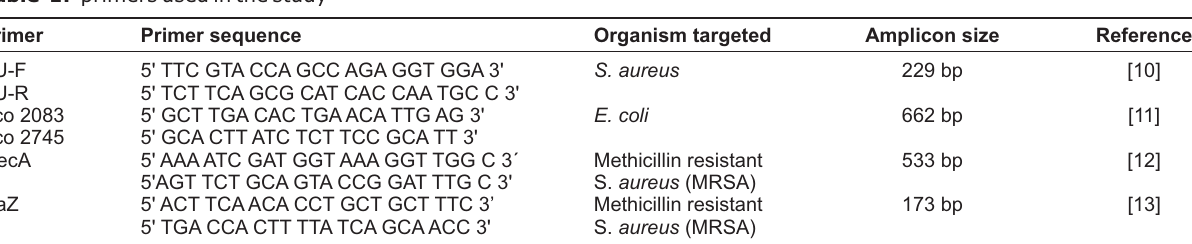
Table-1: primers used in the study Primer Primer sequence Organism targeted Amplicon size